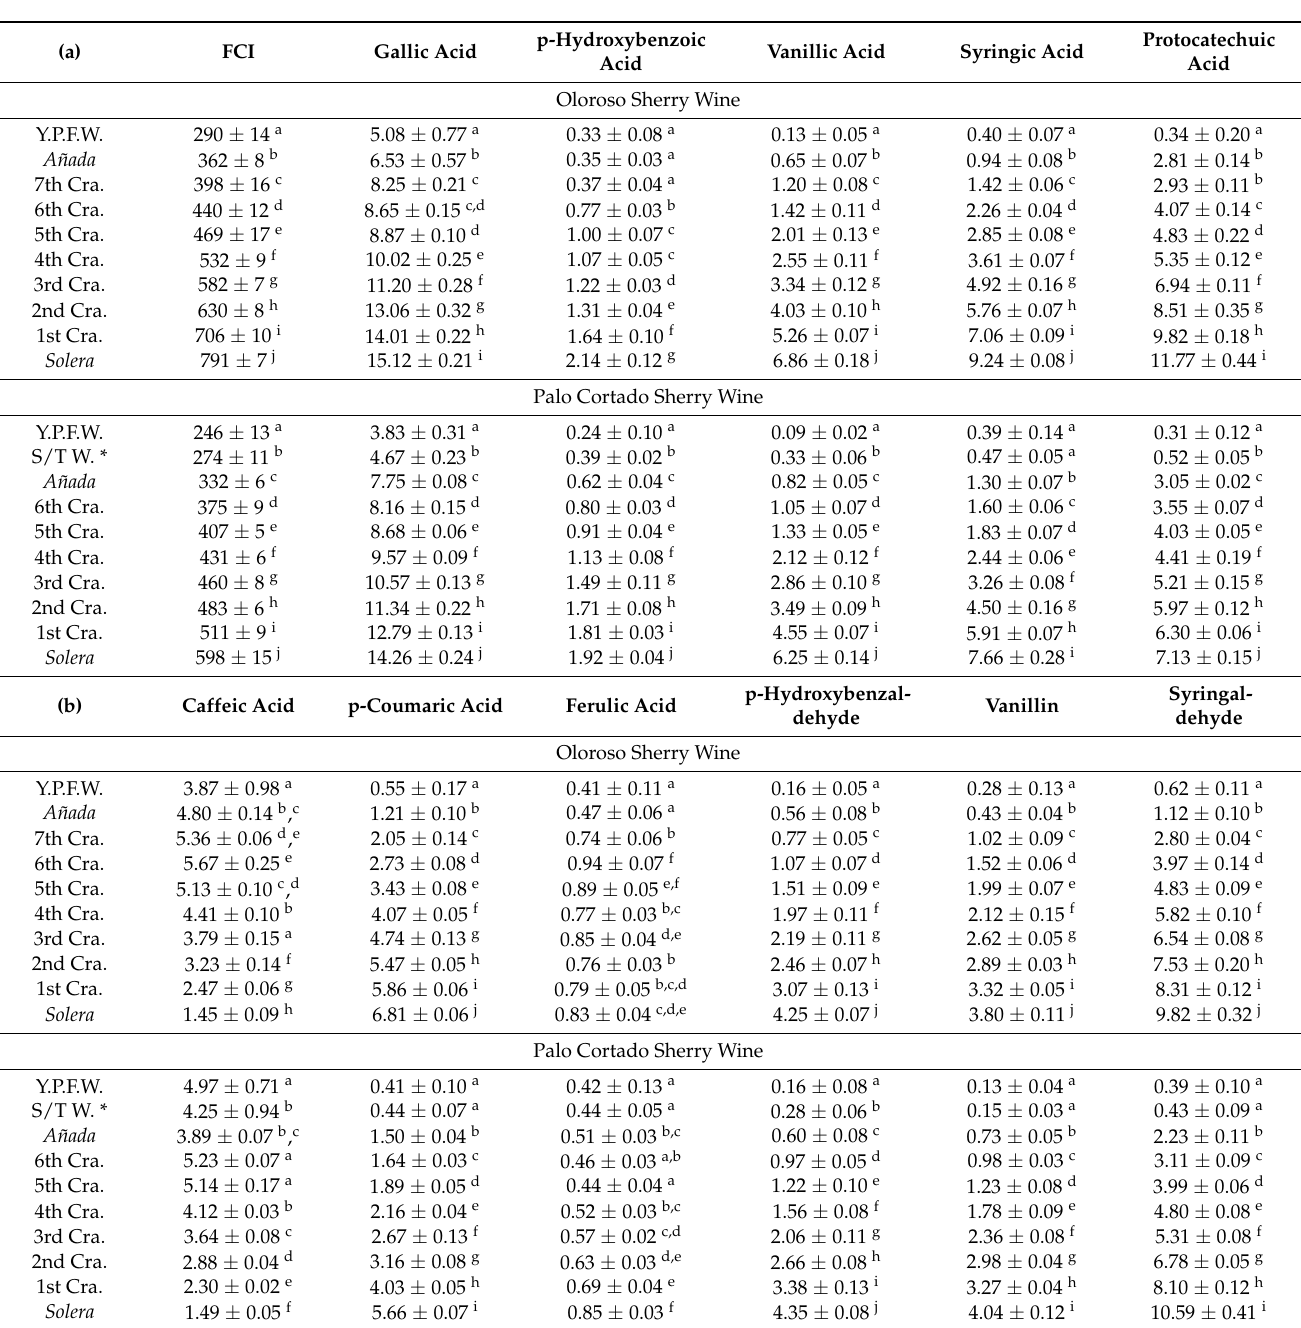
Table 8. (a) Folin–Ciocalteau index FCI (milligrams of gallic acid per liter) and concentration of phenolic compounds (mg/L) in the Oloroso and Palo Cortado Sherry wines studied. (b) Concen- tration of phenolic compounds (mg/L) in the Oloroso and Palo Cortado Sherry wines studied. (c) Concentration of phenolic compounds (mg/L) and furfurals (mg/L) in the Oloroso and Palo Cortado Sherry wines